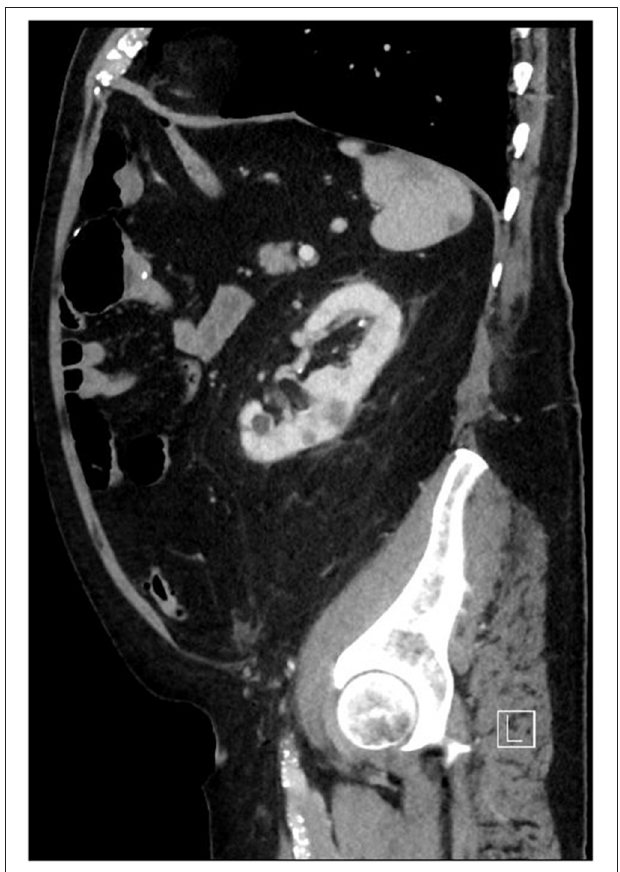
FIGURE 2 | Computed tomography of the chest and abdomen showing septic embolism of the spleen and kidneys.